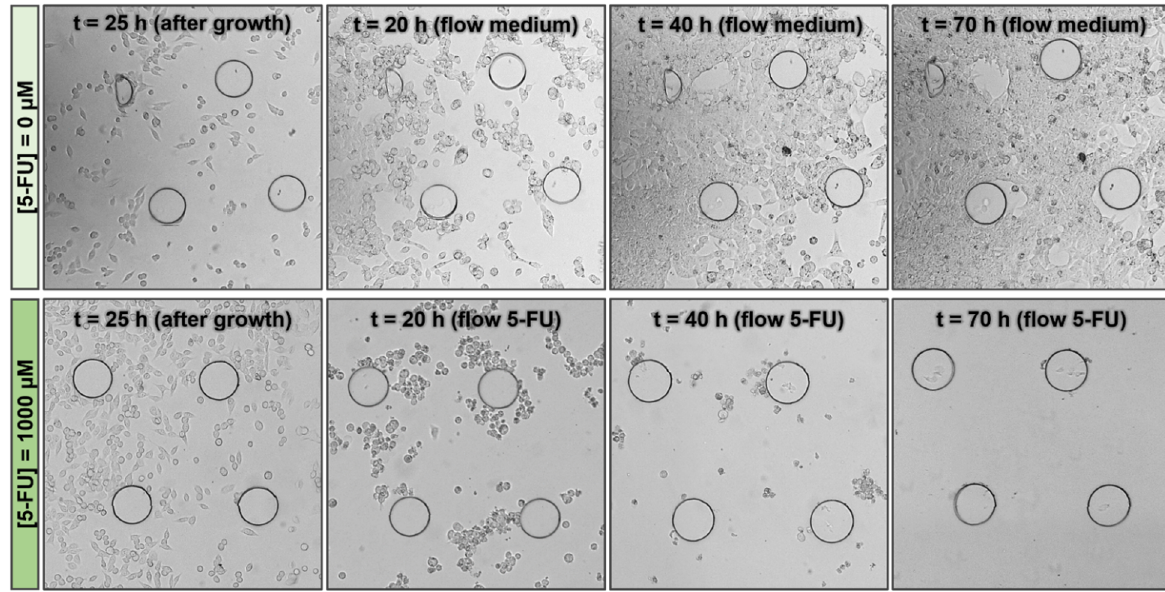
Figure 8. Micrograph of a subsection over time of injection of a specific drug concentration, 0 µ M and 1000 µ M.